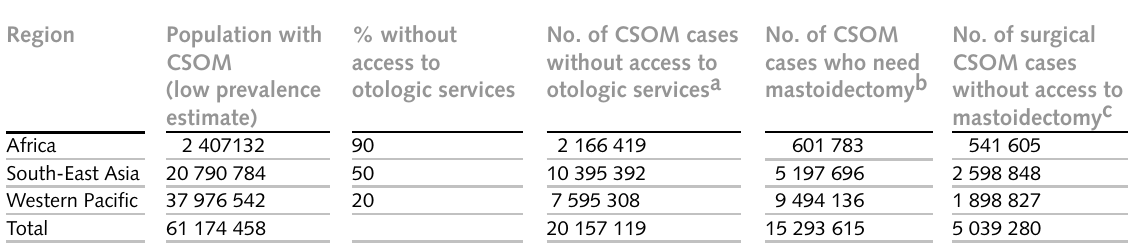
Table 13. Regional distribution of CSOM cases without access to otological services and to mastoidectomy